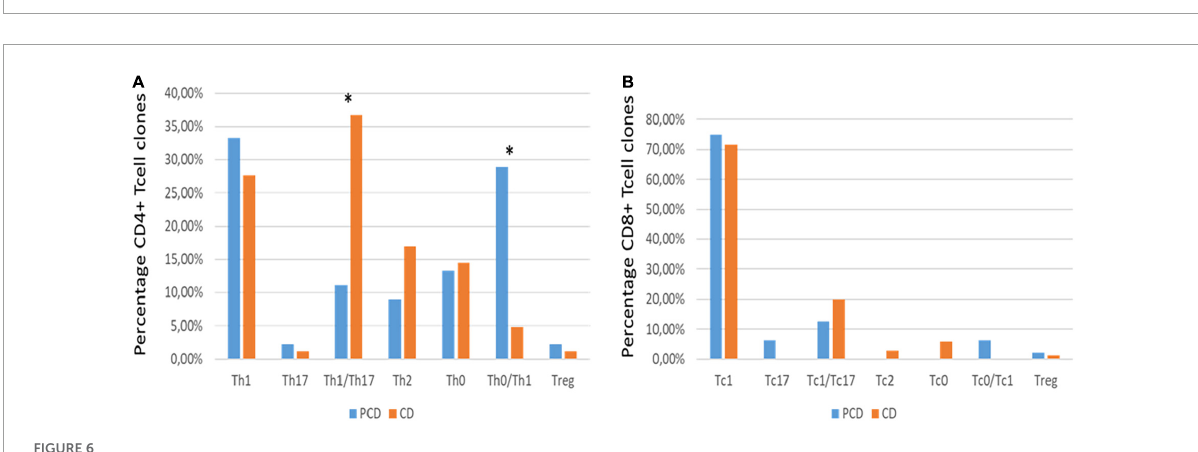
FIGURE5 Percentage of CD4 + and CD8 + T-cell clones, respectively, obtained from the duodenal mucosa of patients with atrophic CD (A) and potential CD (B) .